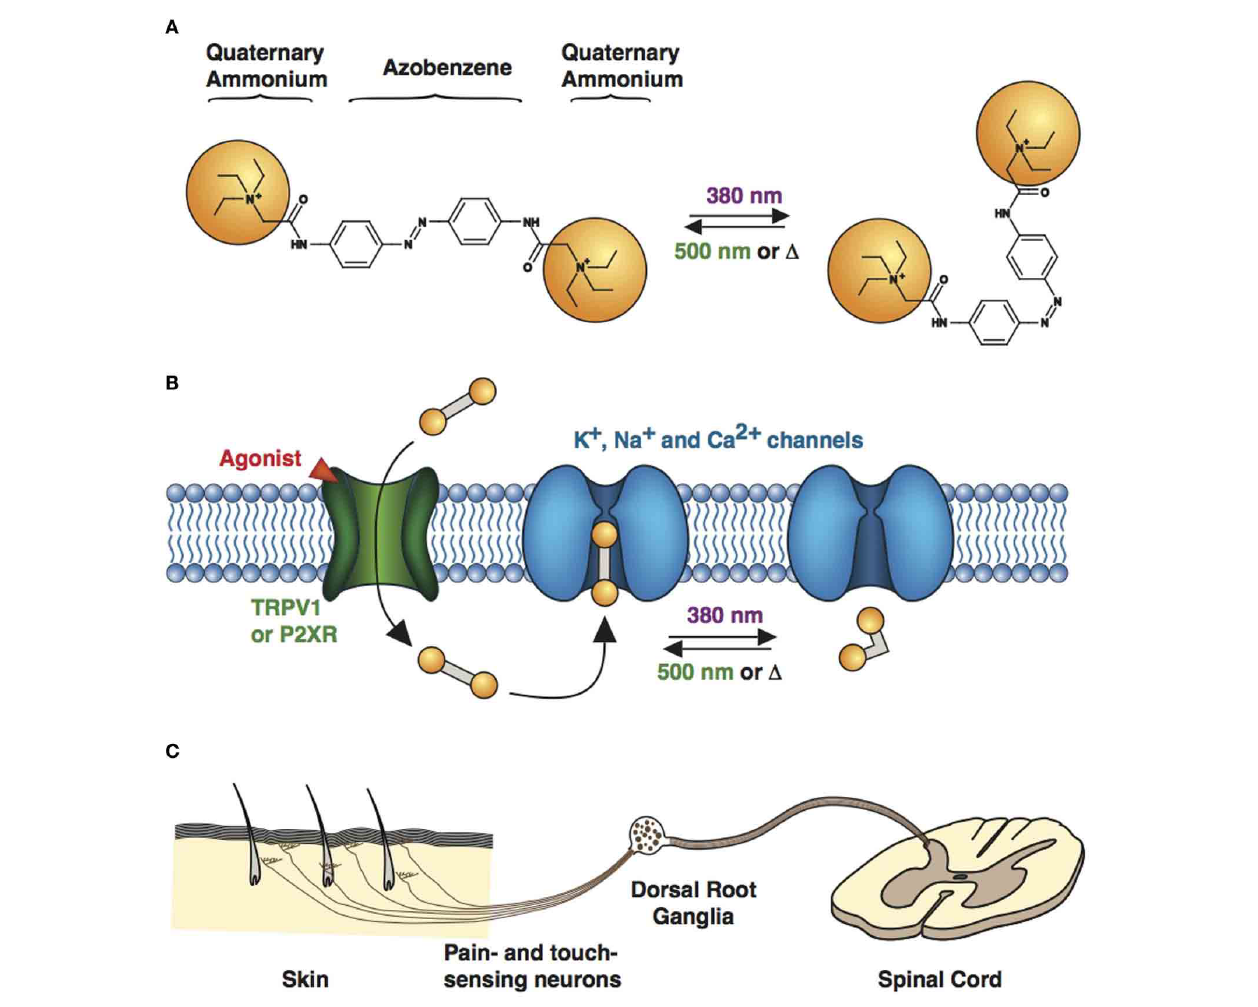
and pain-sensing neurons innervate the skin and project to the spinal cord. Their cell bodies are located in the dorsal root ganglia. QAQ can be targeted specifically to pain-sensing neurons, which contain high densities of TRPV1